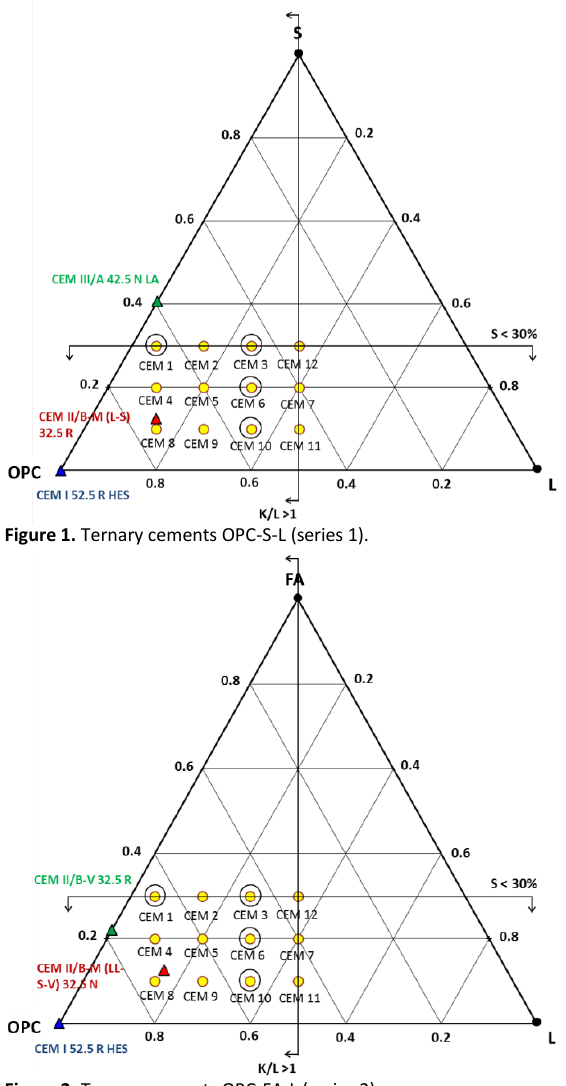
Figure 2. Ternary cements OPC-FA-L (series